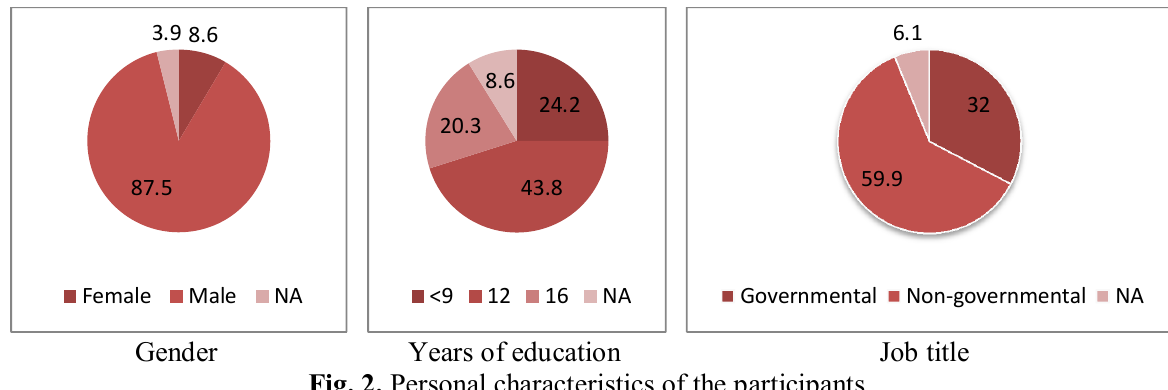
Fig. 2. Personal characteristics of the